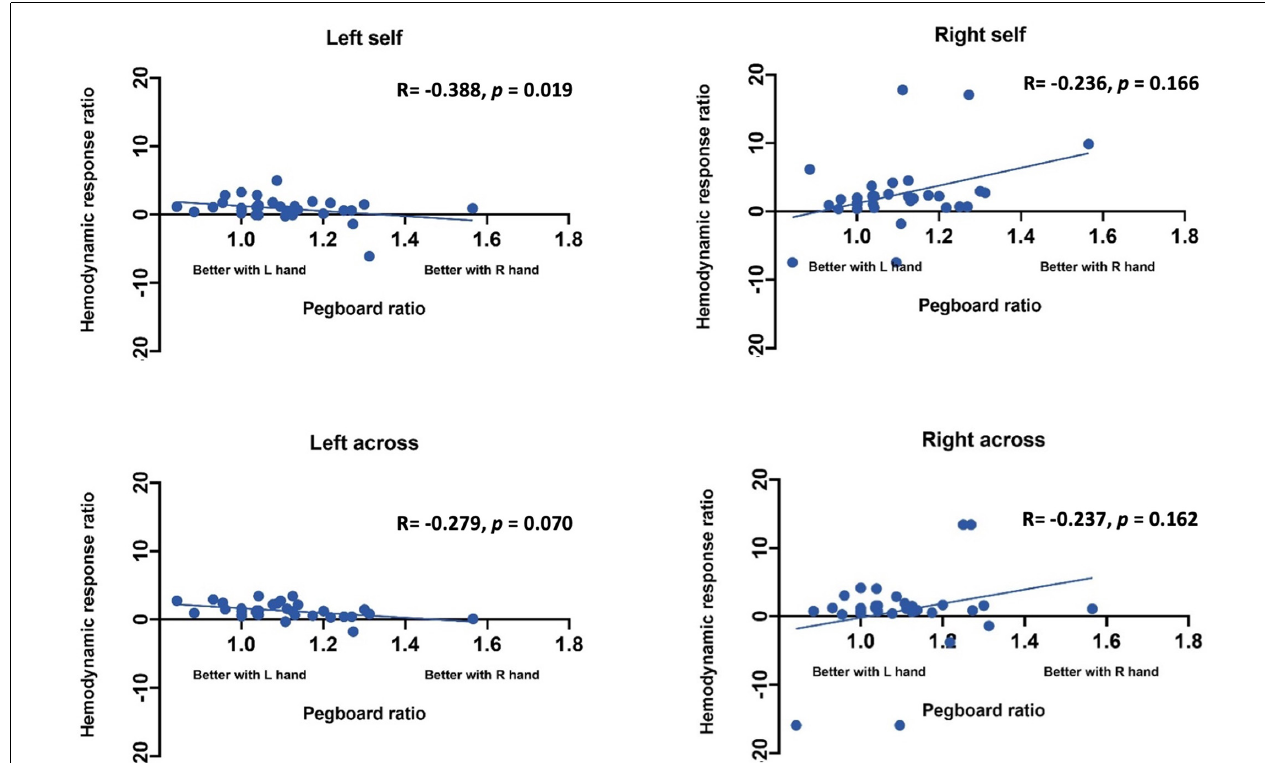
FIGURE 5 | Correlation between ratio of hemodynamic response function and handedness measured by the Purdue Pegboard test.